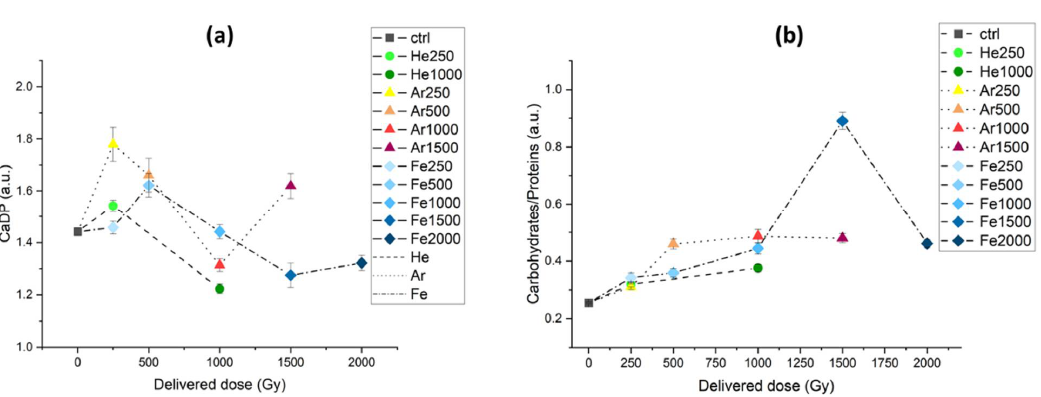
Figure A1. ( a ) Line plot of the Ca 2+ -DPA signal obtained by integrating the 1480–1330 cm − 1 spectral range. ( b ) Line plot of the ratio for carbohydrate signals, calculated as the area of the 1180–950 cm −1 spectral range, over the total protein signals. For all plots, different lines types and colors represent different ions, from lighter colors representing lower doses to darker colors representing higher doses .